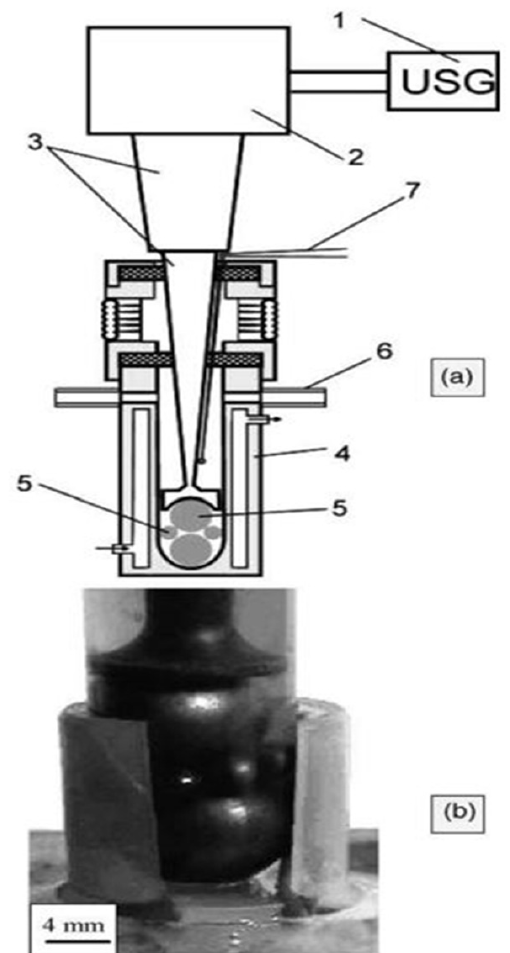
Figure 4. Laboratory Ultrasonic grinding mill for powder processing. ( a ) Scheme: (1) ultrasonic gen- erator; (2) vibrator; (3) step like horn; (4) container; (5) metallic balls; (6) gas inlet; (7) thermocouple.